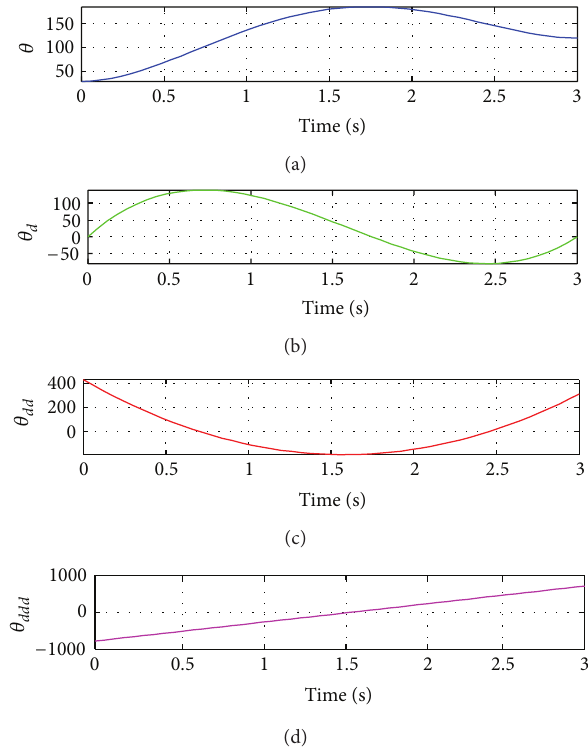
Figure 2: Single fourth-order polynomial with via